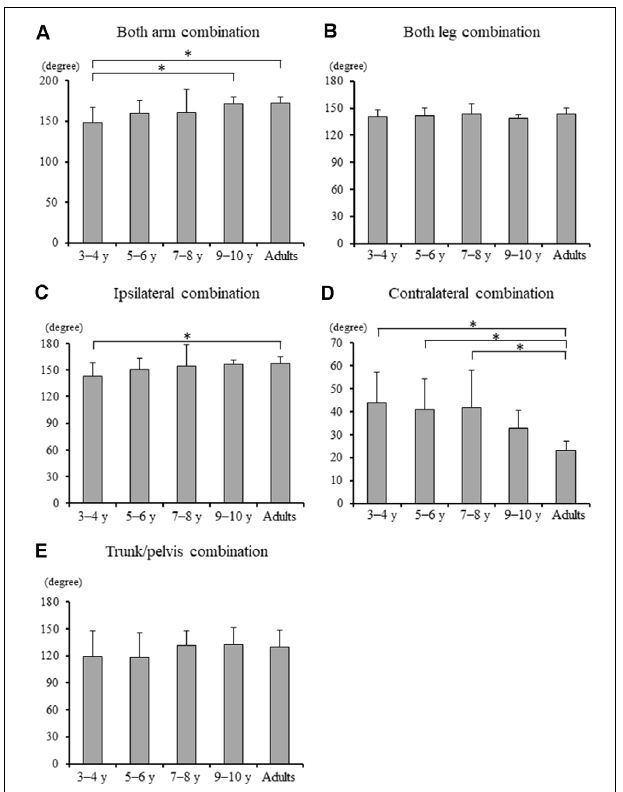
FIGURE 4 | (A) Mean relative phase of both upper arm combination, (B) both upper leg combination, (C) ipsilateral upper arm and leg combination, (D) contralateral upper arm and leg combination, and (E) trunk and pelvis combination for each group [ ± standard deviation (SD)]. ∗ , Significant differences p < 0.05.